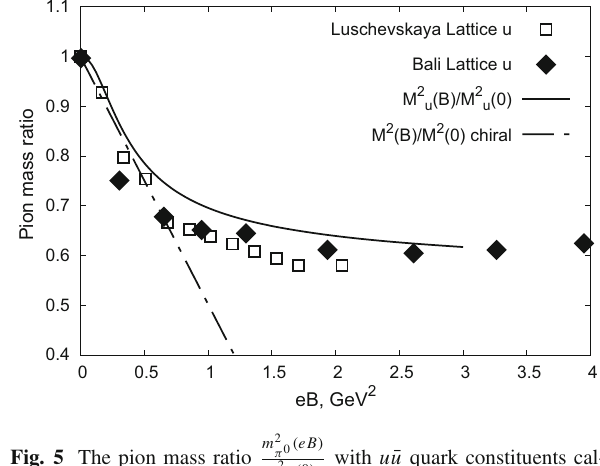
f 2 π 0 ( eB ) for u ¯ u (solid) and d ¯ d (dashed) f 2 π 0 ( 0 )